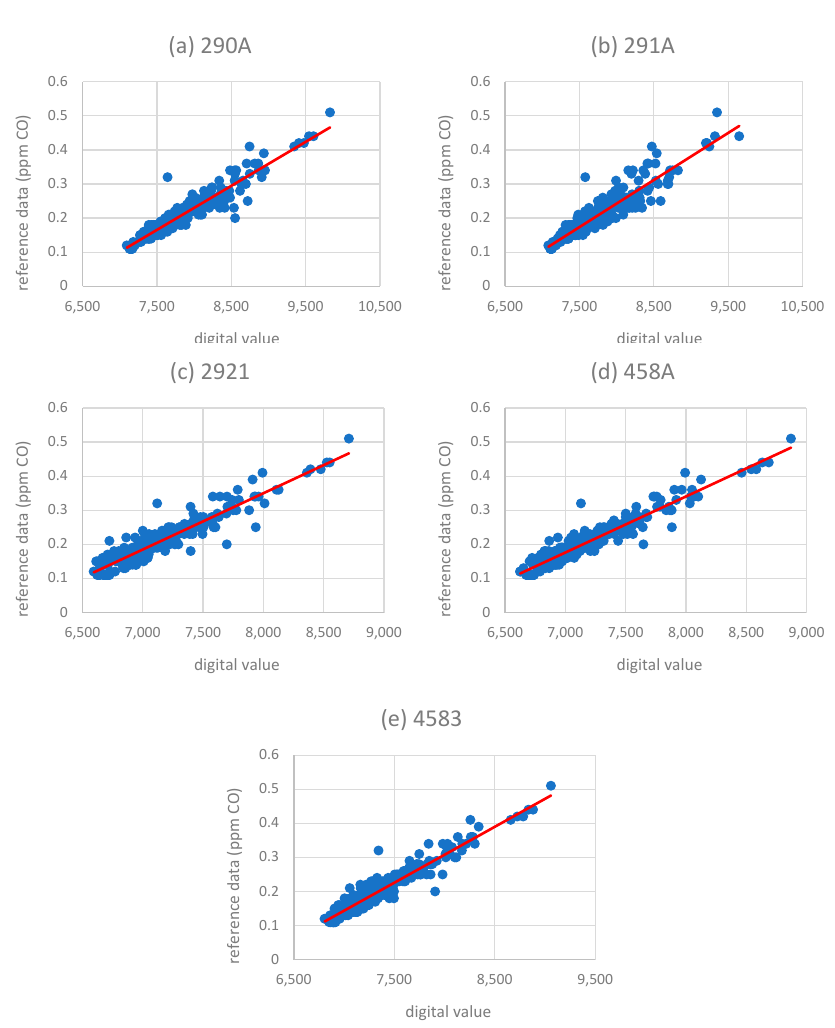
Figure 3. ( a – e ) Plotted data points (blue dots) and trend line (red) for the examined CO sensors.